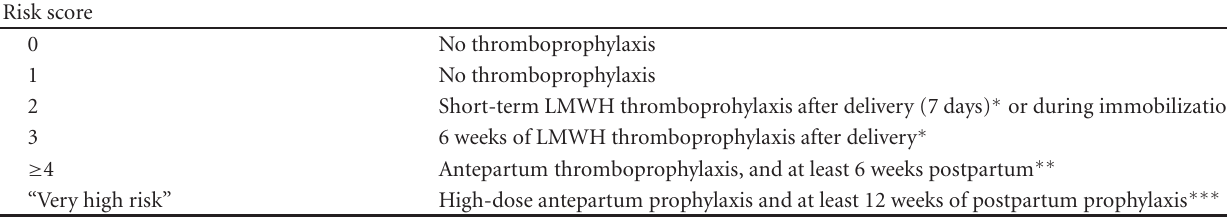
Table 3: Management based on risk score (the sum of riskpoints in Table